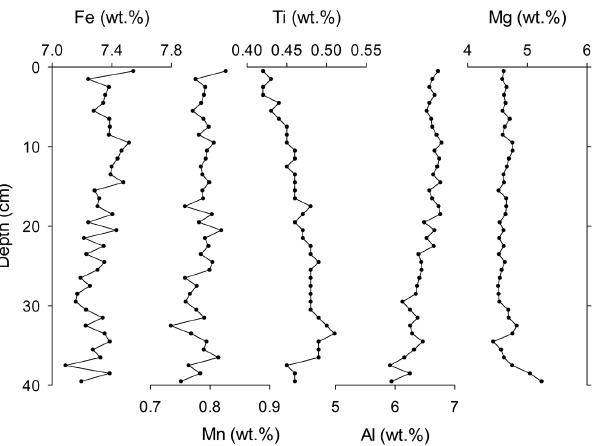
Figure 5. Down-core variations of Fe, Mn, Ti, Al, and Mg measured in the sediment core BC-10. The copper content of the sediment core ranges from 234 to 267 µg/g (average—247.5 µg/g) and is relatively low compared with near-vent metalliferous sediments, which show average values of 17.3% [9]. The concentration of Zn, Pb, Ni, and Cr are 111–195, 25–35, 324–429, and 267–371 µg/g, with an average of 142, 31, 352, and 293 µg/g, respectively (Table S1). Trace metal concentrations of the studied core are relatively higher than the background sediments from the SWIR [20]. Rare-earth element (REE) concentrations were normalized with Post Archean Aus- tralian Shale values (PAAS). PAAS normalized REE patterns (Figure 6) of the bulk sediments exhibit a positive Eu anomaly (Eu/Eu* ratios vary from 1.2 to 1.4) and no Ce anomaly compared with the other lanthanides (Table S2). The REE pattern of the BC-10 sediment core shows lighter REE (LREE) depletion and heavier REE (HREE) enrichment throughout the core. REE patterns characterized by LREE depletion, HREE enrichment, and positive Eu anomaly are similar to the REE pattern of metalliferous sediments from the Central Indian Basin [39].